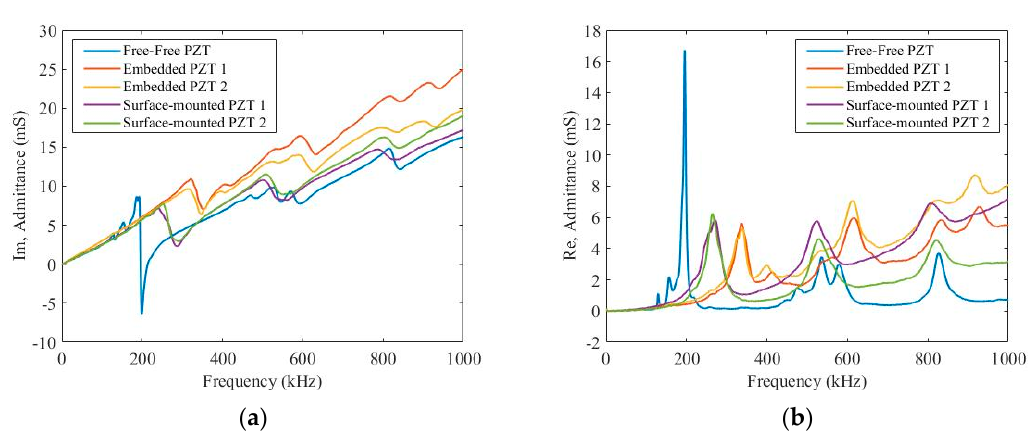
Figure 6. Electrical-Mechanical Impedance (EMI) admittances of ( a ) imaginary parts and ( b ) real parts of free-free, embedded and surface-mounted lead zirconate titanate (PZT) transducers.